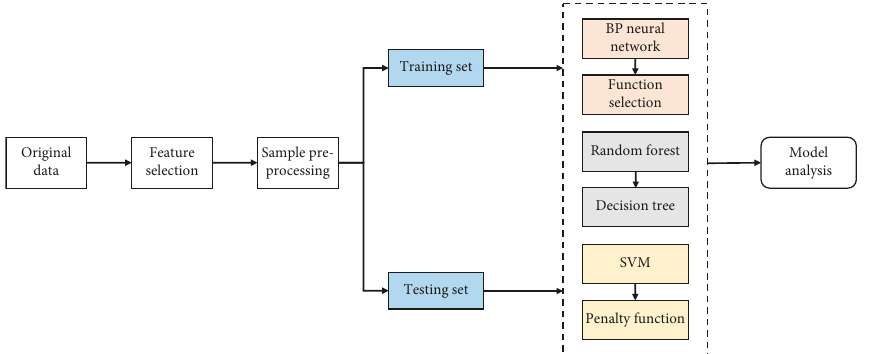
Figure 5: Flow of the audit risk model based on mining algorithms.